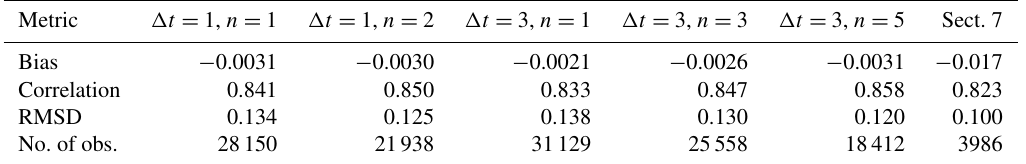
Table 5. Averaged product evaluation with AERONET depending on temporal constraints (pruned Kinne subset). Metric Correlation